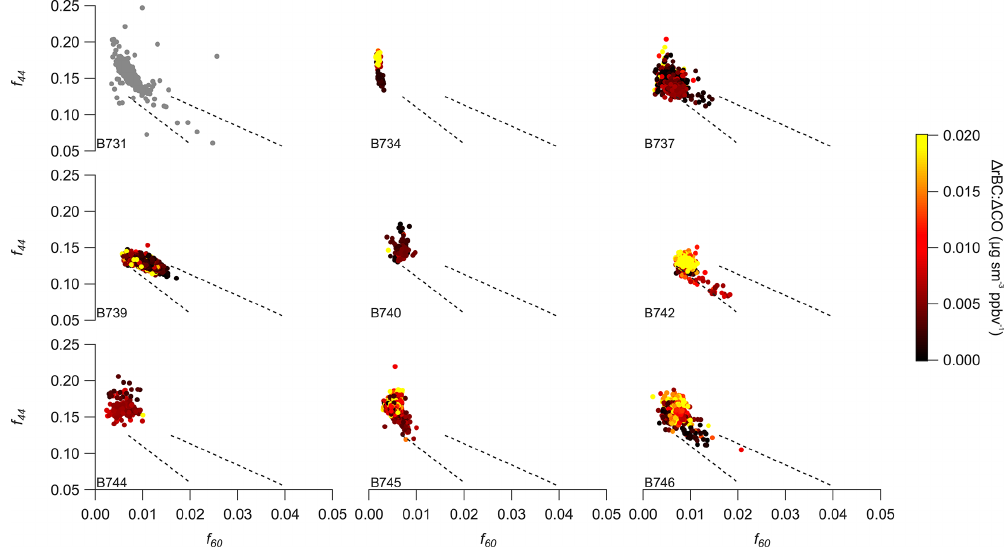
Figure 11. Comparison of f 44 vs. f 60 from the regional analysis across individual flights, where f x refers to the fraction of the organic aerosol mass signal at a given mass-to-charge ratio measured by the aerosol mass spectrometer. Points are coloured according to the ratio of refractory black carbon (rBC) to carbon monoxide (CO) except for B731 where limited rBC data were available. Dashed lines are from previous studies on biomass burning organic aerosol ageing, with the upper line from Cubison et al. (2011) and the lower line from Lack et al. (2013).